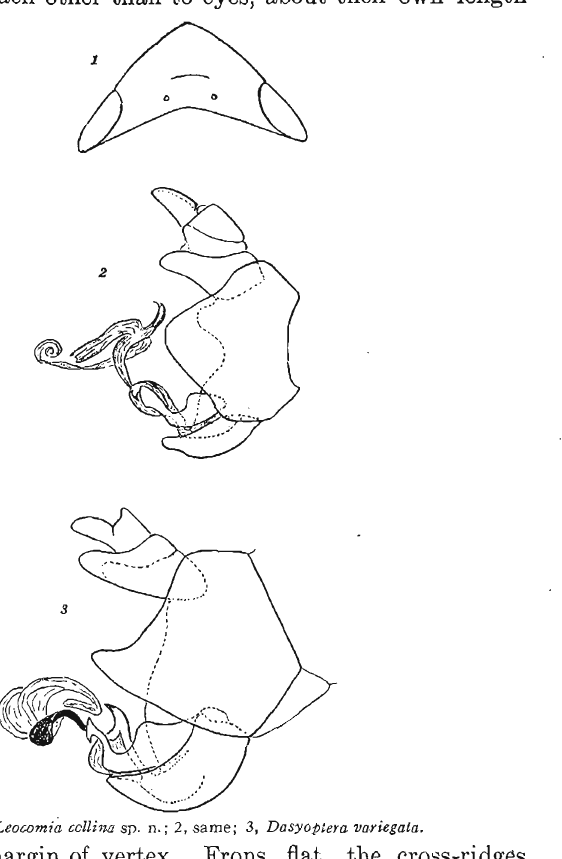
Fig. 1.-1, Leocom'a cclliwa sp. n.; 2, same; 3, Dasyo$Le~a va~iegata. from posterior margin of vertex. Frons flat, the cross-ridges visible only laterally. Pronotum just twice as wide as medianly long, widely subangulately excavated posteriorly. Scutellum 1 . 2 times median length of pronotum, apex long acute, with ineurved sides. Tegmina 2.4 times as long as greatest width; veins very indistinct. Spines on hind tibie very